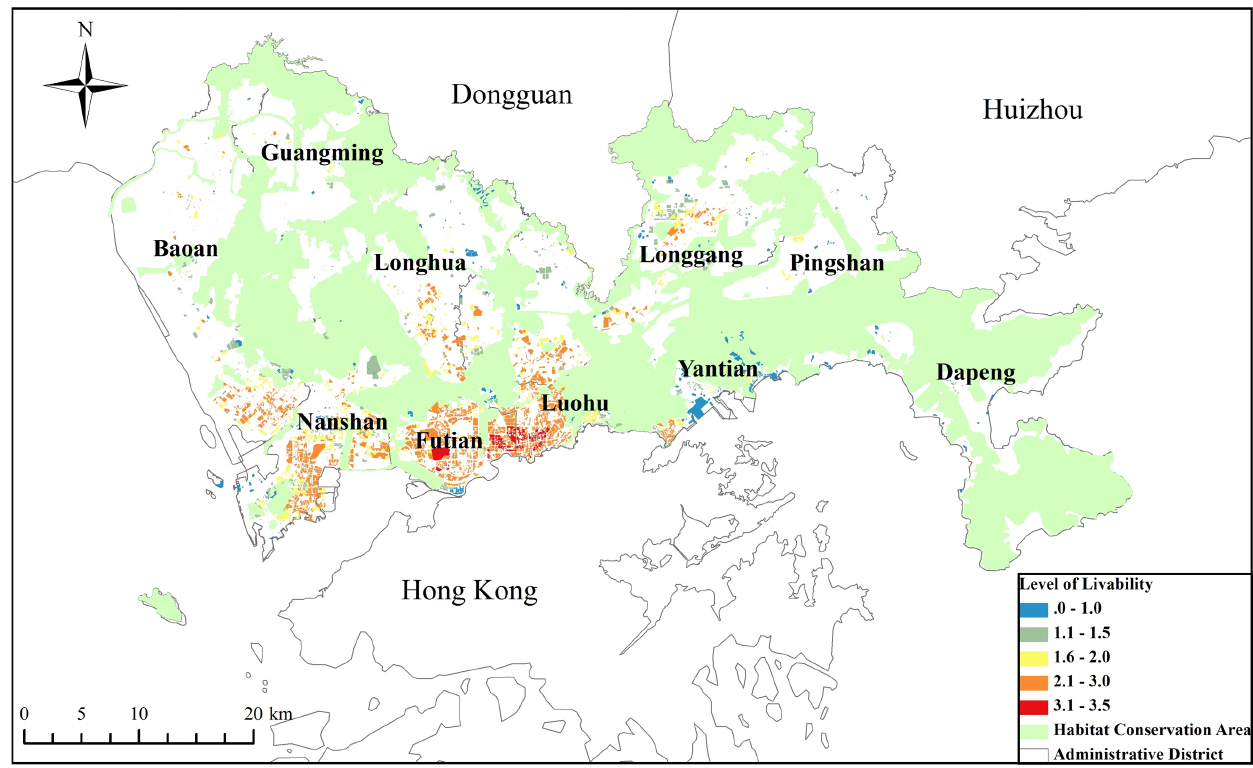
Figure2. Livability of Housing Estate In